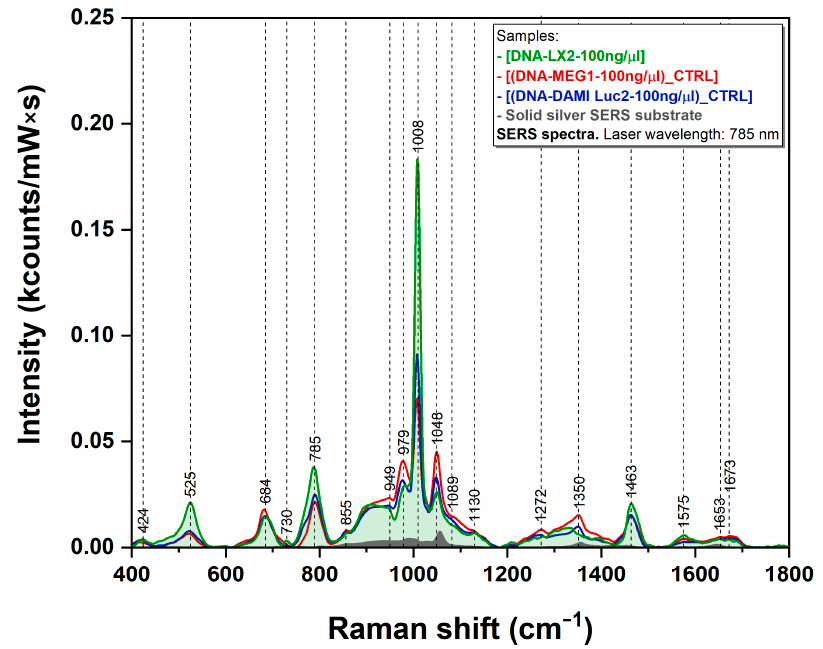
Figure 4. SERS spectra of DNA samples extracted from LX2 normal cell line (green spectrum) and DAMI Luc2 (blue spectrum) and MEG-1 (red spectrum) leukemia cell lines; recorded using a 785 nm laser. The grey spectrum represents the colloidal silver nanoparticles used as the